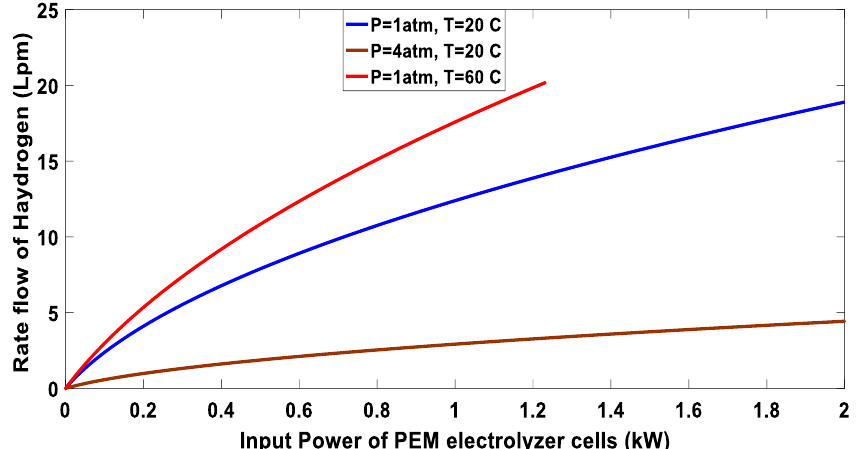
Figure 23. Flow rate of hydrogen vs. input current of PEM electrolyzer at different operating conditions.